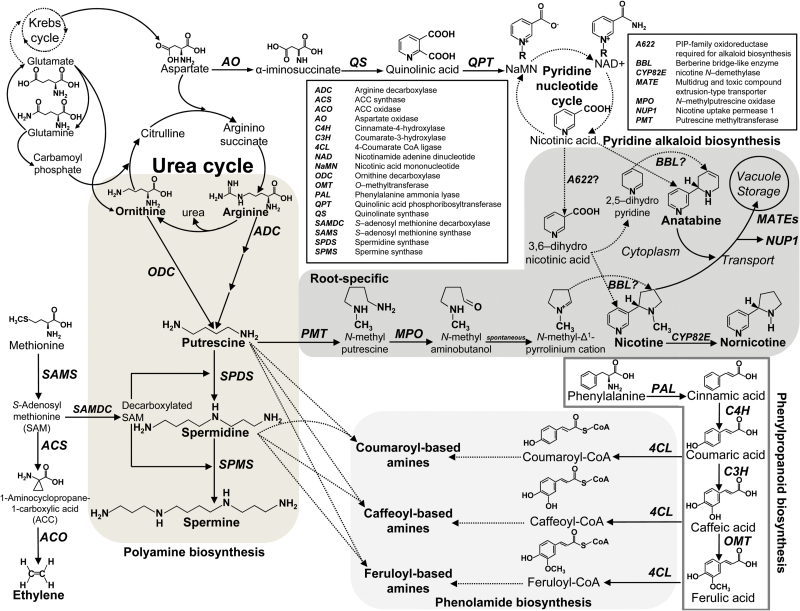
Schematic diagram of the biosynthesis of polyamines and connections with other metabolic pathways, including pyridine alkaloid, phenolamide and phenylpropanoid metabolism, in N. tabacum (adapted from Cane et al., 2005; Onkokesung et al., 2012; Shoji and Hashimoto, 2012; Winter et al., 2015). Solid lines indicate defined steps, while dotted lines indicate undefined steps or steps including multiple reactions. Both pyridine alkaloid and polyamine/phenolamide metabolites share early biosynthetic steps, starting from arginine and ornithine to produce putrescine. The biosynthesis of alkaloids in tobacco occurs mainly in roots, while the phenolamide and phenylpropanoid pathways are present predominantly in above-ground (leaf) tissues. The final condensation reactions with nicotinic acid derivatives and N-methyl pyrrolinium cation are not yet clear; however, it is suggested that a PIP-family isoflavone reductase-like protein, A622, is involved in the late step of synthesis of the pyridine moiety prior to synthesis steps involving enzymes from a Berberine Bridge Like gene family. Several toxin transport proteins including MATEs and NUP1 are involved in vacuolar storage and transport of alkaloids to aerial tissues (Shoji et al., 2009; Morita et al., 2009; Hildreth et al., 2011; Shitan et al., 2014a,b).